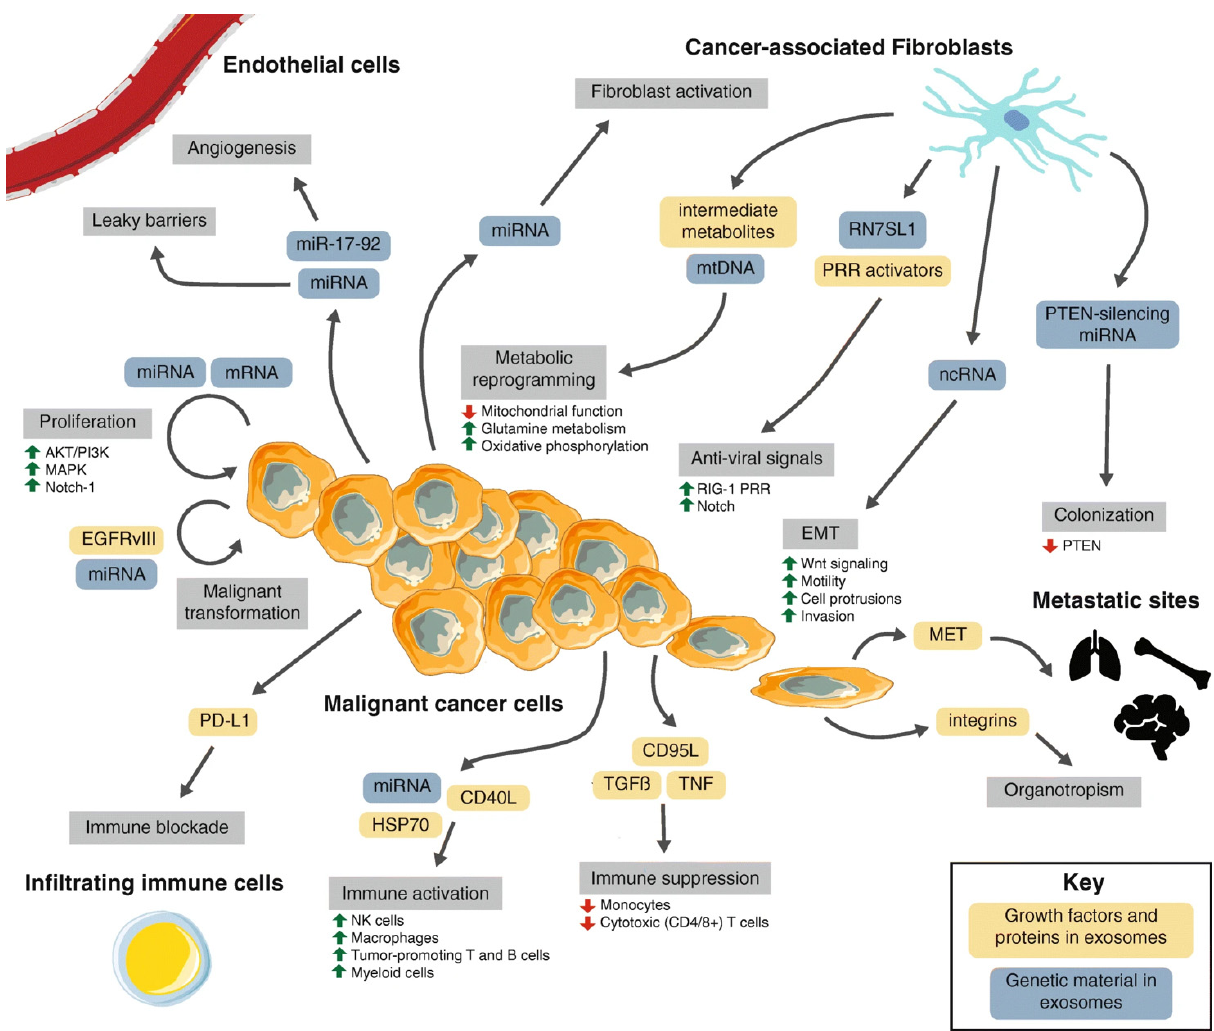
Figure 1. Tumor microenvironment interactions. A macroscopic view of the molecular crosstalk between cancer-associated fibroblasts, endothelial vasculature, infiltrating immune cells, and malignant cells in the TME. Dynamic interactions governed by heterotypic signaling mechanisms between cell types modulate various stages of cancer progression (grey boxes). The role of exosomes in this cell-cell signaling is highlighted (blue and orange boxes). From Li et al. [7].